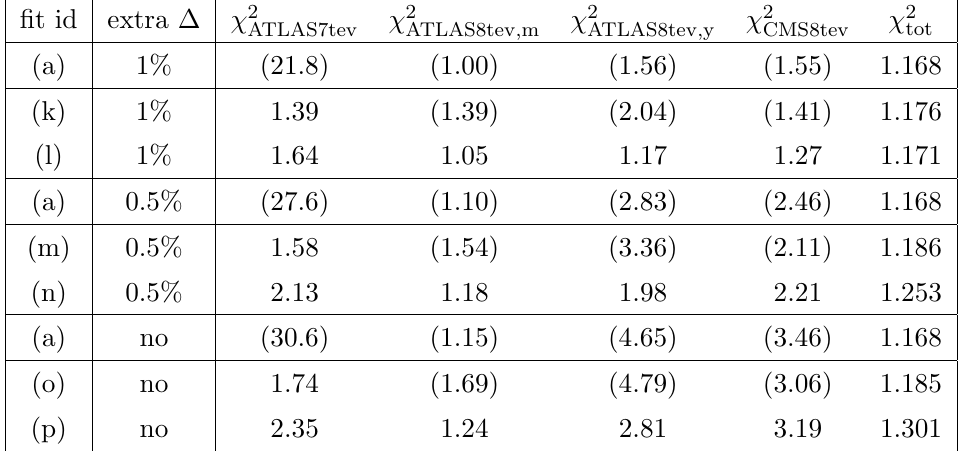
Table 8 . Fully correlated (cid:31) 2 for the (cid:12)ts described in table 7. The numbers in brackets corre- d : o : f : spond to the (cid:31) 2 for experiments which are not (cid:12)tted. The total (cid:31) 2 is computed over all baseline HERA data the included p Z T